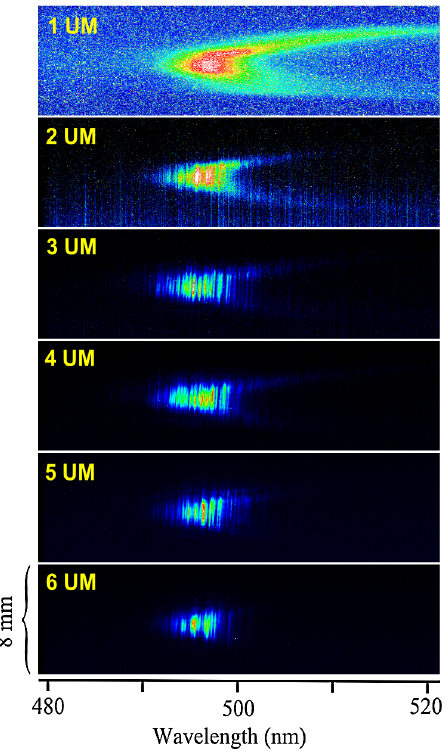
FIG. 15. Evolution of the spectrum during the exponential gain growth. The number of sections closed is reported on the upper left corner. The vertical axis in each picture indicates the position on the vertical entrance slit of the